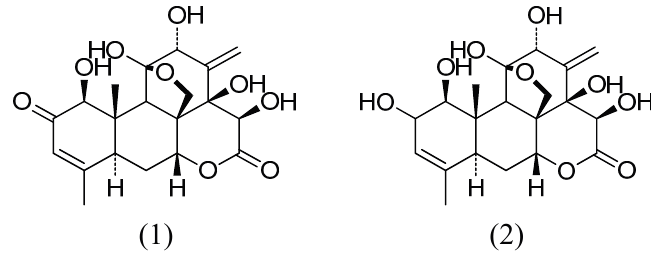
Figure 1. Quassinoid structures of eurycomanone (1) and eurycomanol